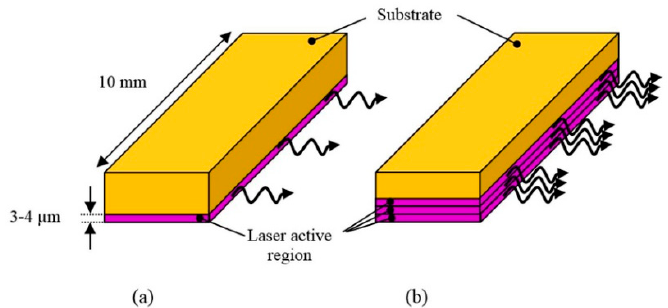
Figure 13. Schematic diagram of ( a ) a standard diode bar and ( b ) a multiple active region diode bar. Adapted with permission from Proc. SPIE 9887, Biophotonics: Photonic Solutions for Better Health Care V, 98872B (2016). Copyright 2016 Society of Photo-Optical Instrumentation Engineers (SPIE).